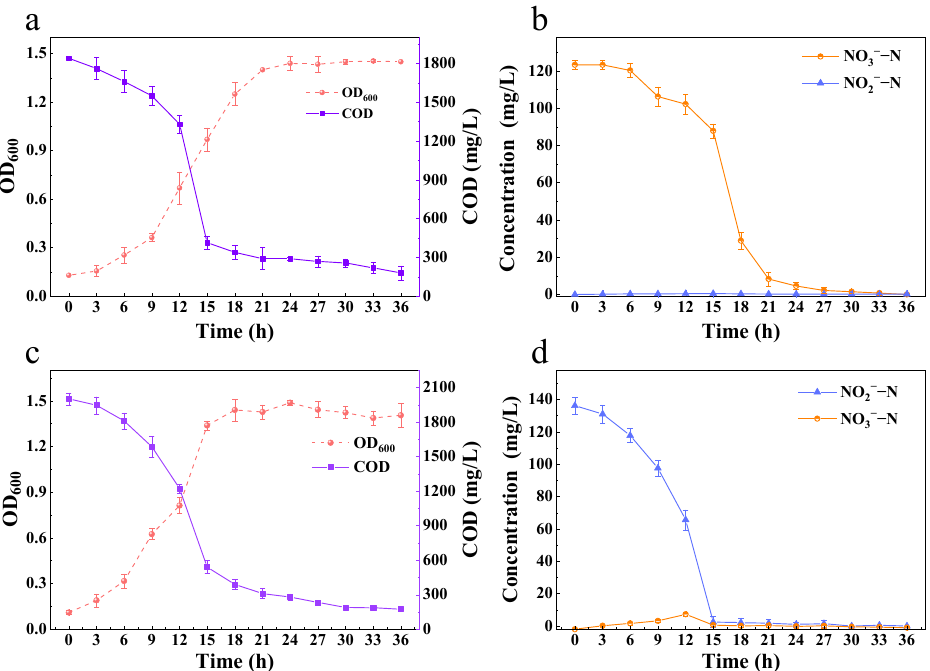
Figure 4. Aerobic denitrification characteristics of strain LY1024 with NO 3 − -N ( a , b ) and NO 2 − -N ( c , d ) as the solo nitrogen source.